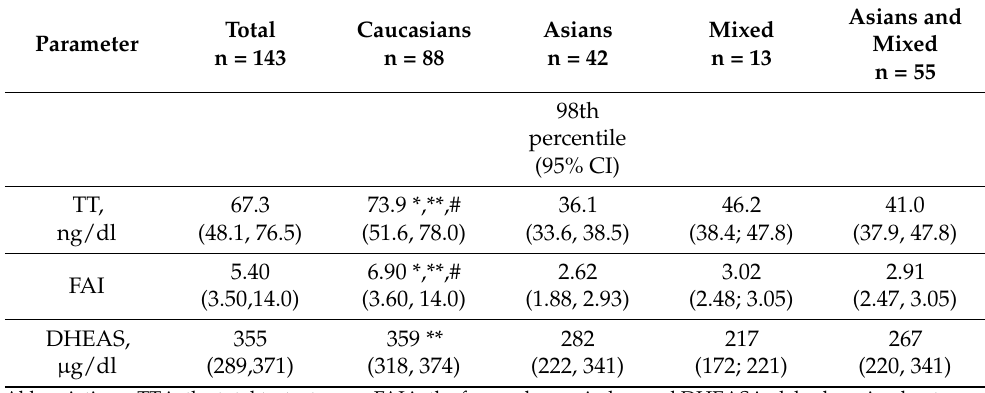
Table 5. The UNLs for androgens as defined by the 98th percentiles in healthy